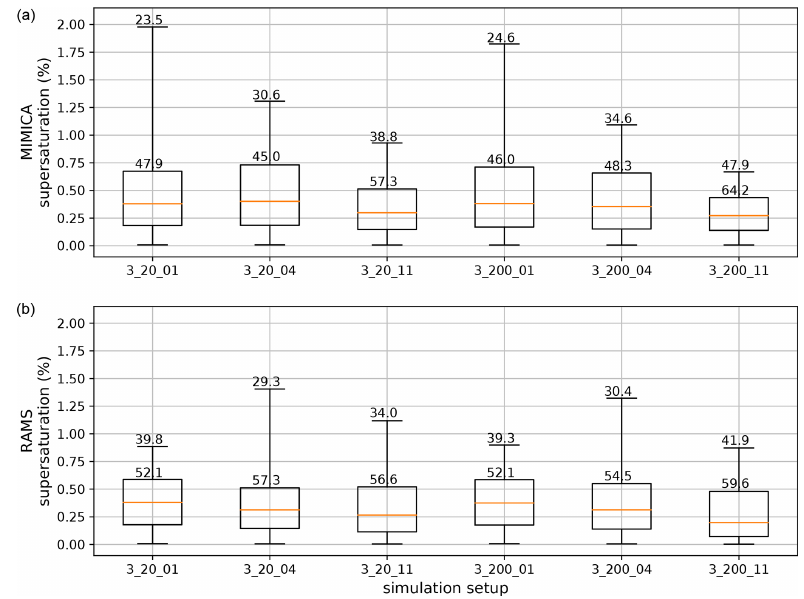
Figure 15. Supersaturation statistics shown for the simulations AC3_AK20 and AC3_AK200 initialized with different κ values, which are 0.1, 0.4 and 1.1, simulated by MIMICA and RAMS. The statistics are calculated for a 20min period around 6h of simulation for all grid boxes with relative humidity > 100%. Lower and upper whiskers correspond to 1st and 99th percentiles, respectively. The numbers written in the figure are critical dry diameters that correspond to supersaturation 75th percentiles (upper limit of the box) and 99th percentiles. For figure clarity, the plot titles have been abbreviated; the first number refers to the accumulation mode and the second to the Aitken mode concentration in cubic centimetres, i.e. 3_20_01 refers to AC3_AK20 initialized with a κ value of 0.1.